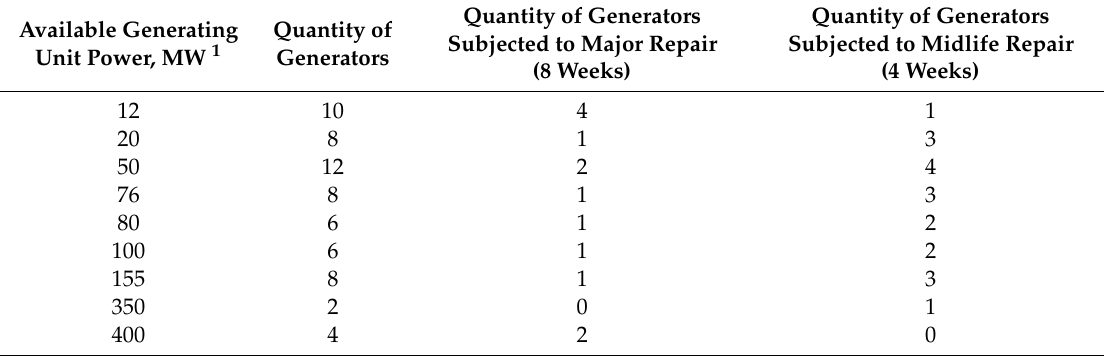
Table 2. The generation profile of the second test system and the quantity of generators subjected to major and midlife repair.